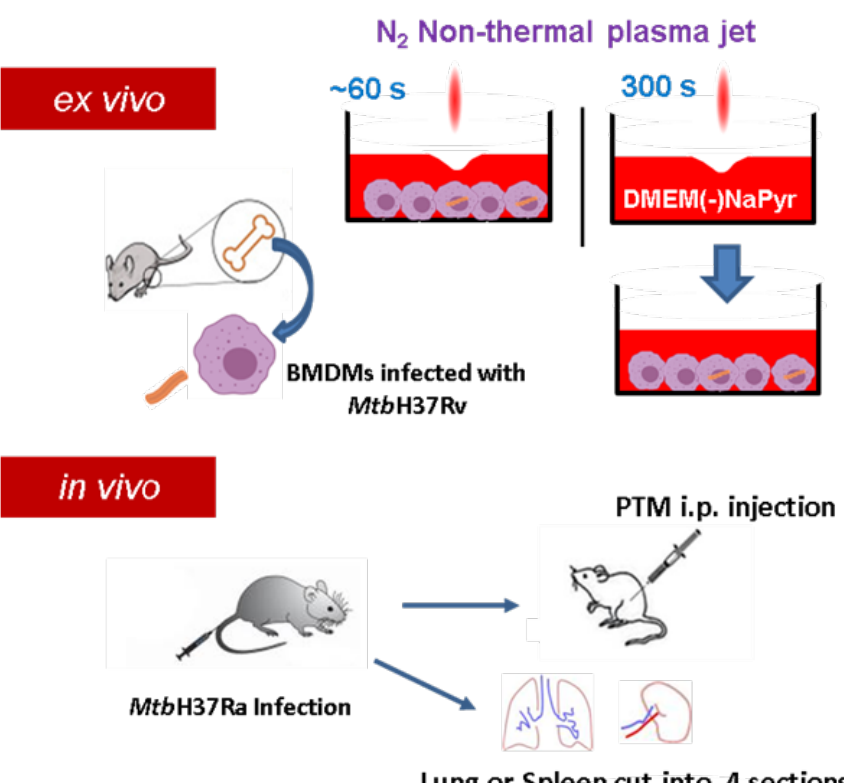
Figure 1. Scheme of non-thermal plasma jet to treat infected or uninfected cells ex vivo and in vivo . Cell cultures were exposed to a non-thermal plasma jet (NTPJ) ex vivo by placing the plasma exit 5 mm above medium surface for 30–60 s. Medium (DMEM) was exposed to NTPJ for 300 s to generate PTM. First mice were infected with Mtb H37Ra and after two or three weeks, the mice were injected intraperitoneally (i.p.) with PTM. Additionally, the spleens and lungs were obtained from the infected mice, cut into four pieces, and suspended into single cells, before exposure to PTM.